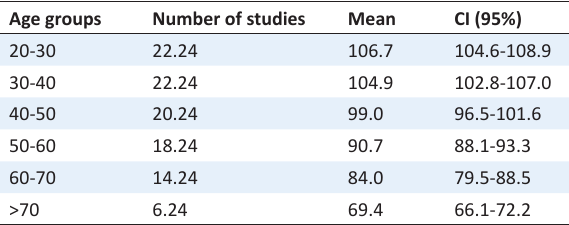
elimination from the final analysis can be